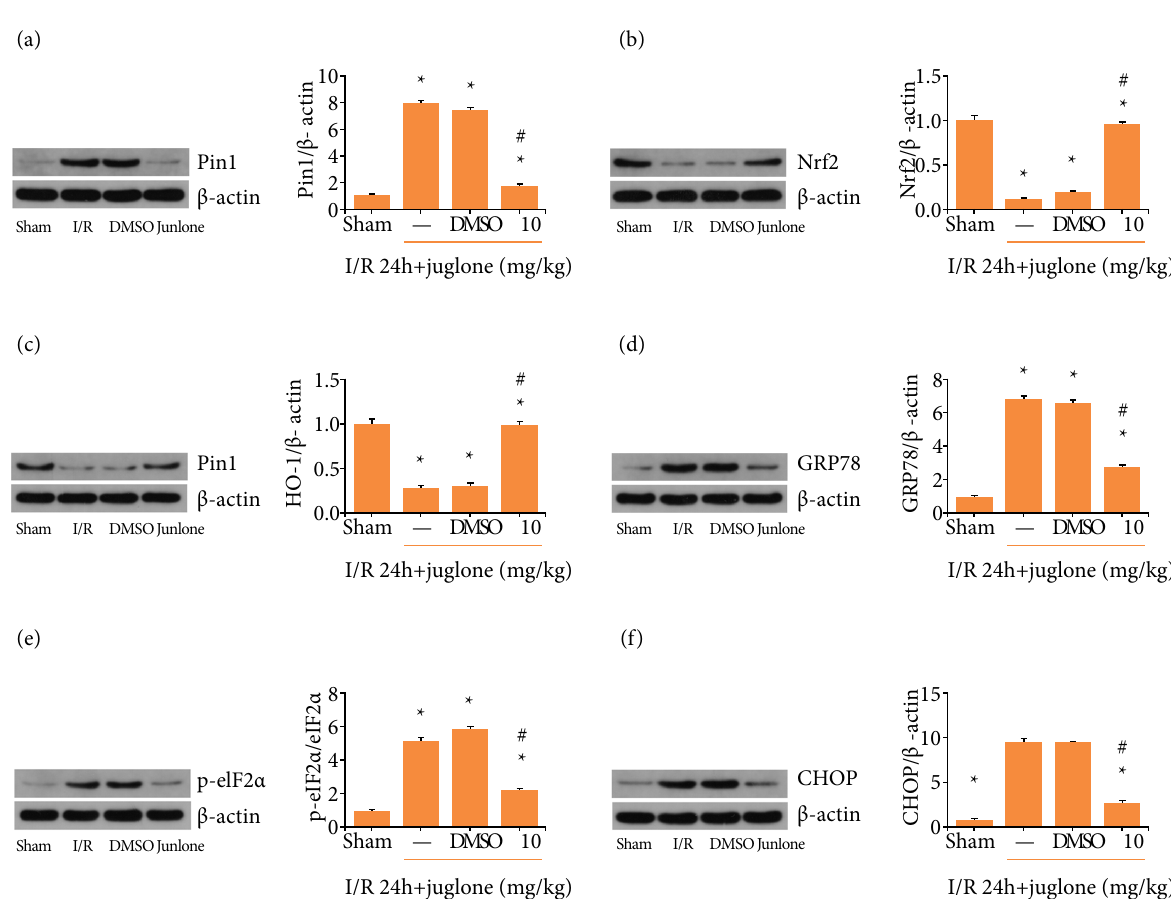
Figure 3 - Pin1 inhibitor ameliorates endoplasmic reticulum stress and Nrf-2/HO1 pathway. (a) The effect of Pin1 inhibitor (10 mg∙kg –1 ) on Pin1 expression in rats exposed to renal ischemia 45 min and reperfusion 24 h,